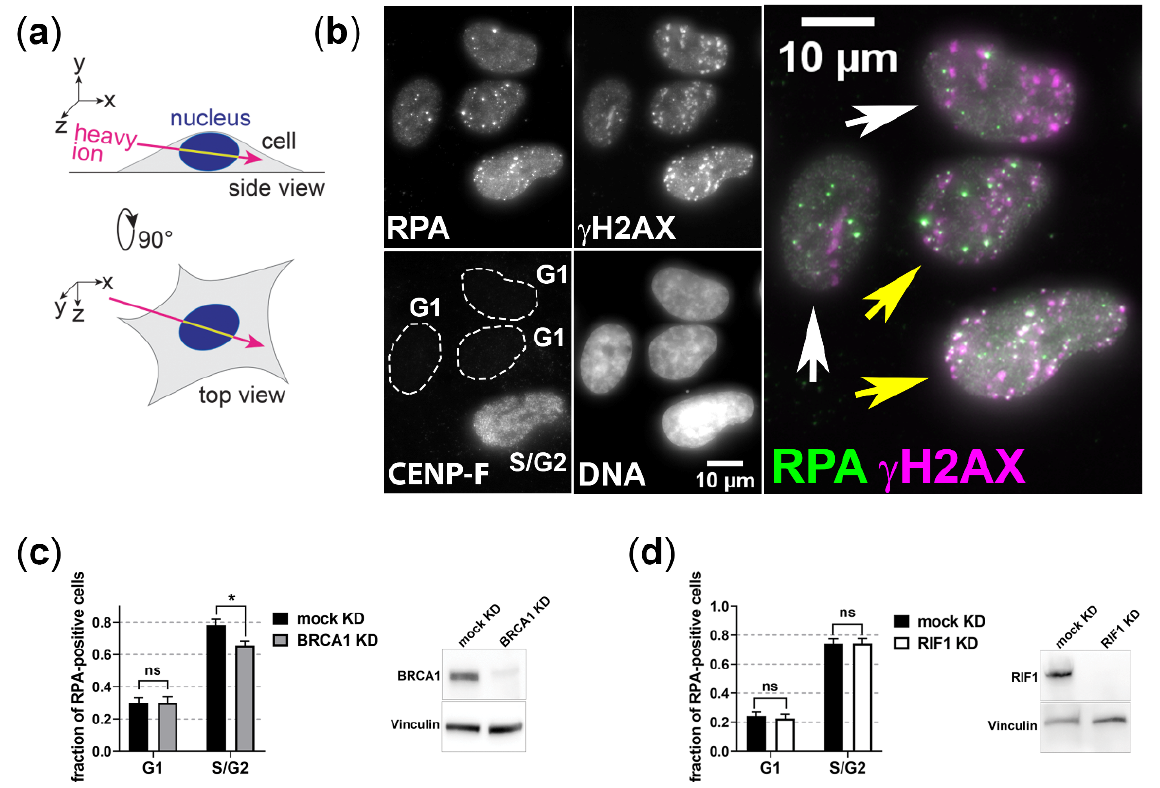
Figure 1. BRCA1 and RIF1 do not modulate resection of complex DSBs induced in G1-phase cells. U2OS cells were depleted for BRCA1 (BRCA1 KD) or RIF1 (RIF1 KD) by RNAi or mock depleted and irradiated with 5 × 10 6 carbon ions/cm 2 (6.5 MeV/nucleon) in a low angle. The depletion was proven by western-blot analysis. 1 h after irradiation cells were fixed for immunofluorescence staining of the resection marker RPA, the DSB marker γ H2AX, and the cell-cycle marker CENP-F (CENP-F positive: S, G2, and M phase; CENP-F negative: G1 phase). DNA was visualized by DAPI staining, which allowed distinguishing M-phase cells. Irradiated cells (i.e., cells with streak-like γ H2AX signal) that show colocalization of RPA-with γ H2AX along the ion track were counted RPA positive (yellow arrows); those that show no colocalization of RPA and γ H2AX were counted RPA negative (white arrows). The experiments were performed twice and at least 100 cells per condition were analyzed. Error bars: SEM. Two-tailed Mann-Whitney test, p values: ns, not significant; * p < 0.05. ( a ) Scheme of angular heavy-ion irradiation of culture cells, which causes streak-like patterns of ion traversals. ( b ) Representative image of carbon-ion-induced RPA signal in G1 and S/G2 cells. ( c ) Quantitative analysis of irradiated RPA-positive G1 and S/G2 cells depleted or mock depleted for BRCA1. ( d ) Quantitative analysis of irradiated RPA-positive G1 and S/G2 cells depleted or mock depleted for RIF1.